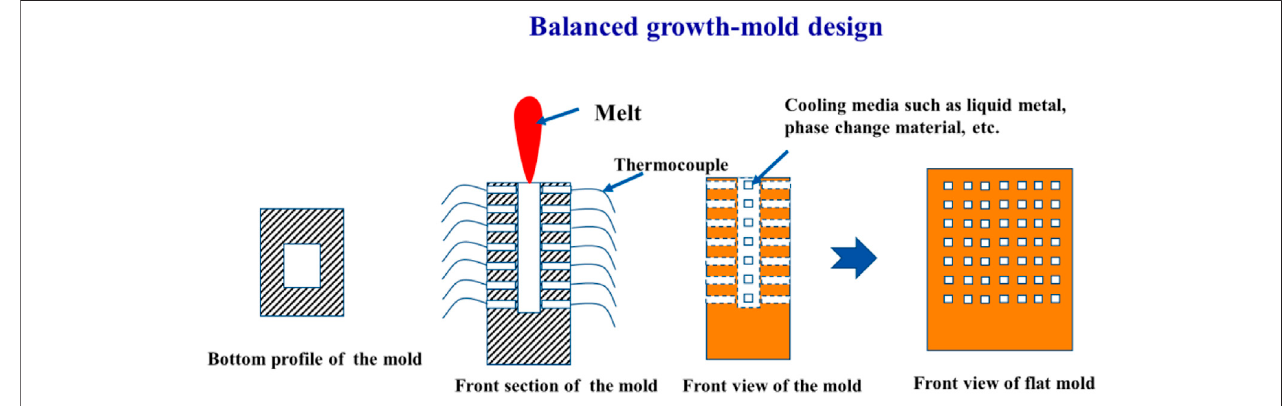
FIGURE 10 | Schematic diagram of the mold